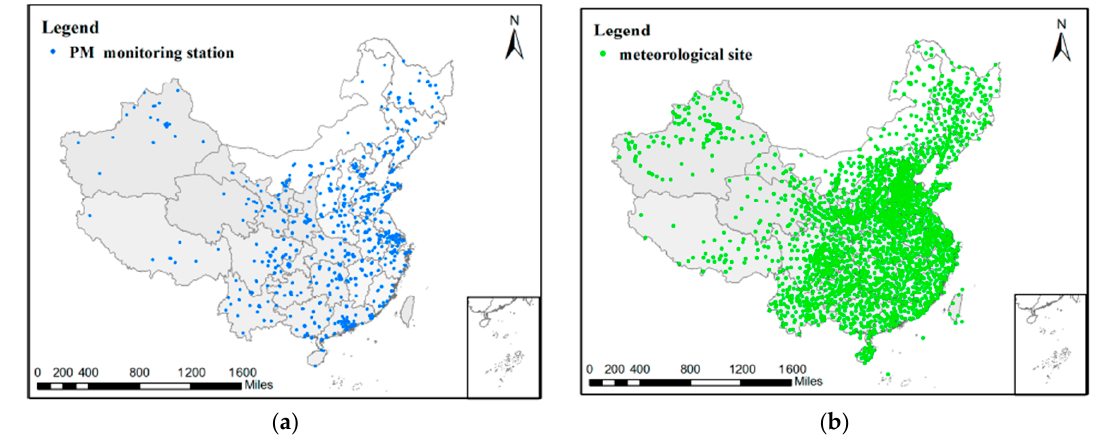
Figure 2. The distribution of: ( a ) PM 2.5 monitoring stations; and ( b ) meteorological stations in China